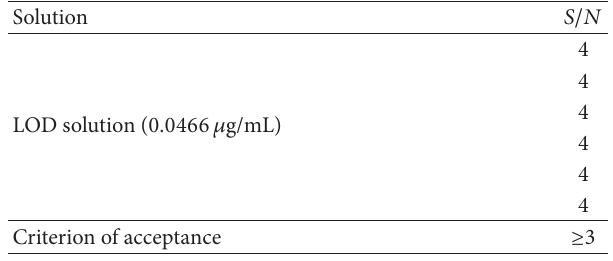
Table 4: Results: calculation of approximate LOQ.